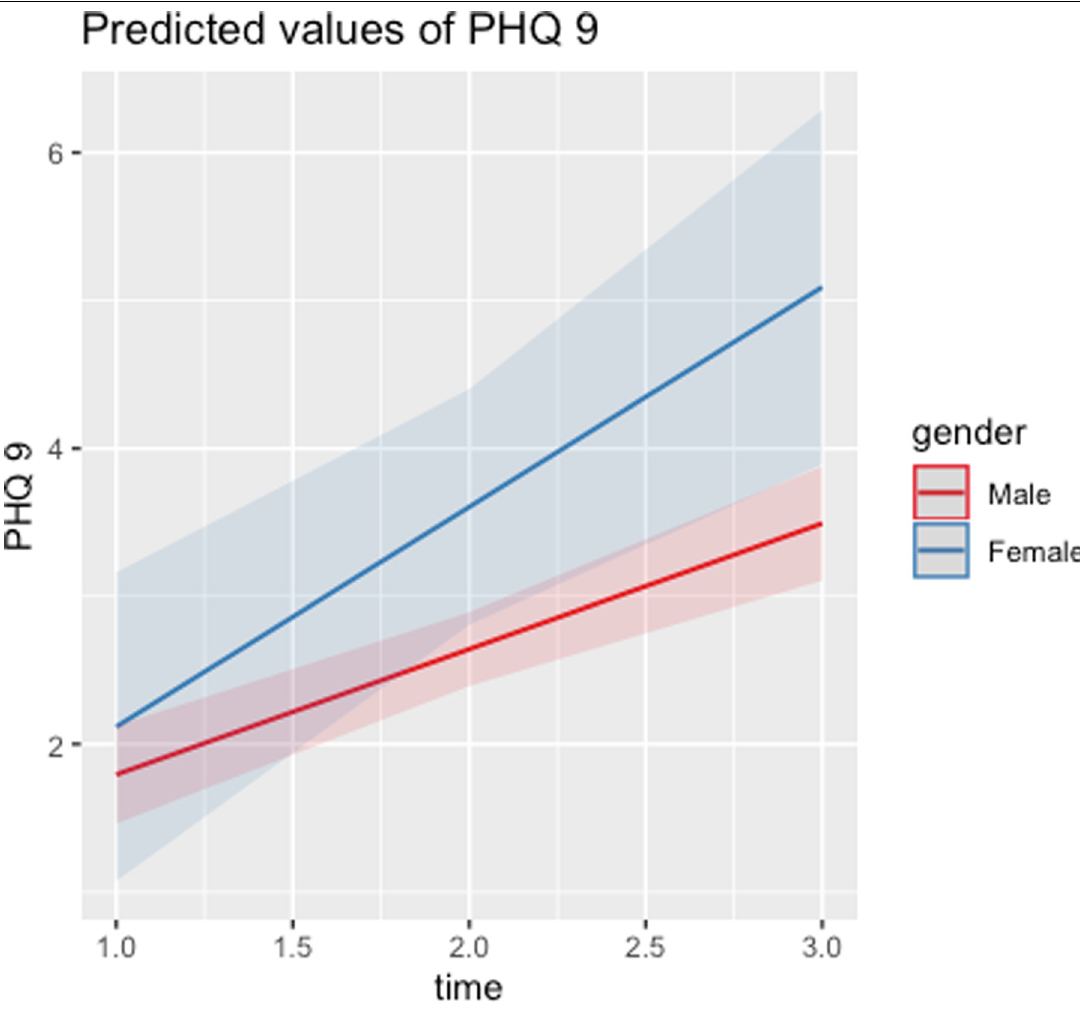
Fig 2. Predicted values of PHQ-9 across time: Males vs.